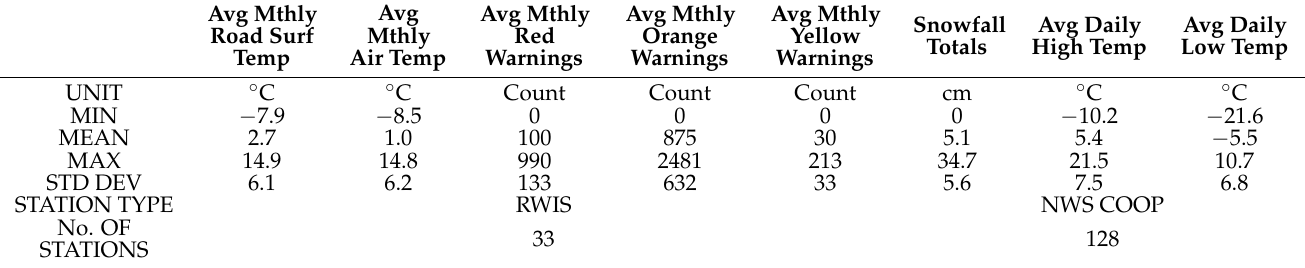
Table 1. Summary statistics for the environmental covariates.